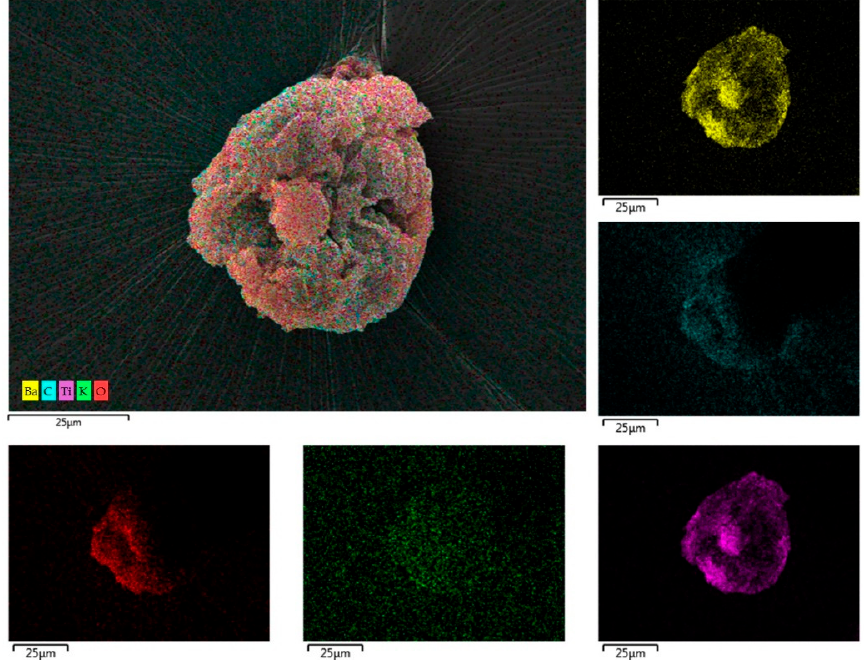
Figure 3. FE-SEM/EDS data for DST single shot sample. A representative GSR particle on DST from the single shot sampling shows the morphology and elemental composition. The elemental overlay of Ba (yellow), K (green), Ti (purple), O (red), and C (blue) along with a combined image (in the top left) are displayed at 1000× magnification; the scale bars indicate 25 µm.